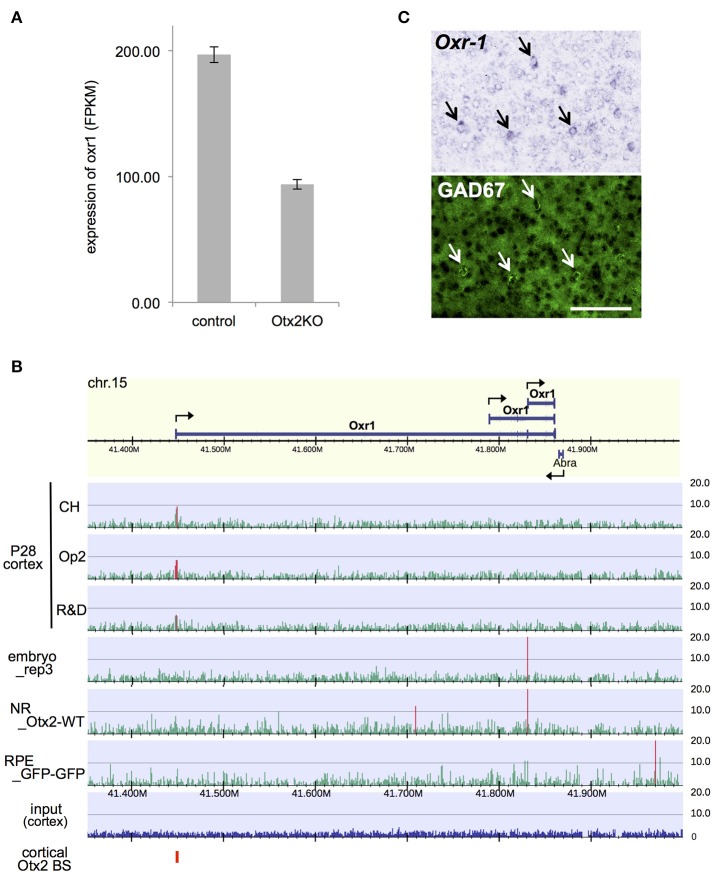
Otx2 regulates expression of anti-oxidant gene Oxr1 in cortical interneurons. (A) Reduction of Oxr1 expression in Otx2-deficient interneuron. Expression level is shown in FPKM (fragments per kilobase of transcript per million fragments). (B) Otx2 binding sites across Oxr1 region in different stages/tissues. NR, neural retina. (C) Co-localization of Oxr1 transcripts (in situ hybridization) and GAD67 immunofluorescent signal (green) in the primary visual cortex of P28 mouse. Arrows indicate Oxr1- and GAD67-positive interneurons. Scale bar, 100 μm.